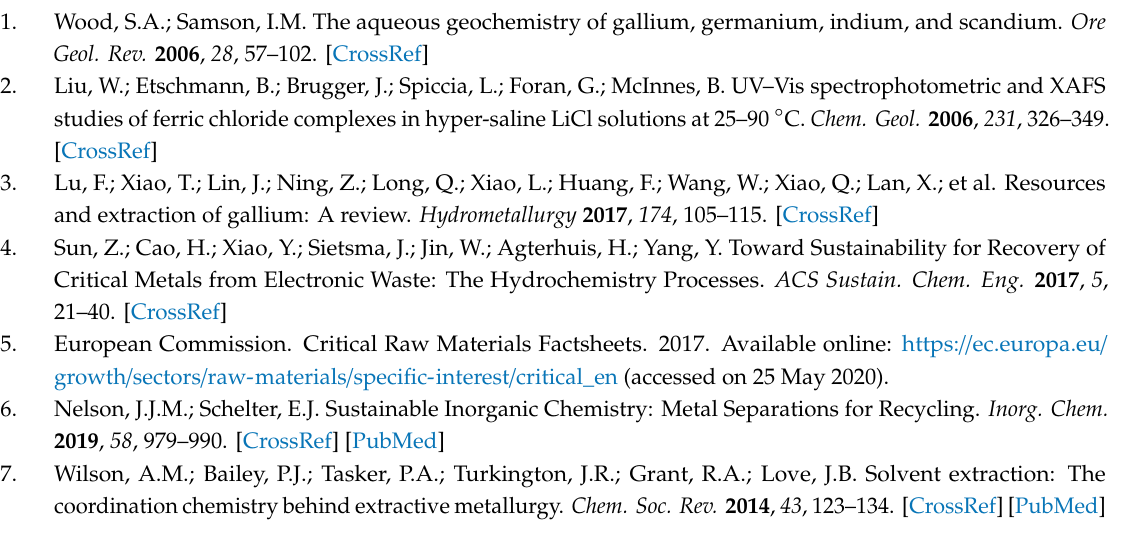
Supplementary Materials: The following supplementary materials are available online. Figure S1: Negative ion ESI-MS of [MTOA][I] in toluene after contact with FeCl 3 and GaCl 3 in 2 M HCl. Figure S2: Positive ion ESI-MS of [MTOA][I] in toluene after contact with FeCl 3 and GaCl 3 in 2 M HCl. Figure S3: Slope analysis for the transport of Ga by [MTOA][I] with varying [H +